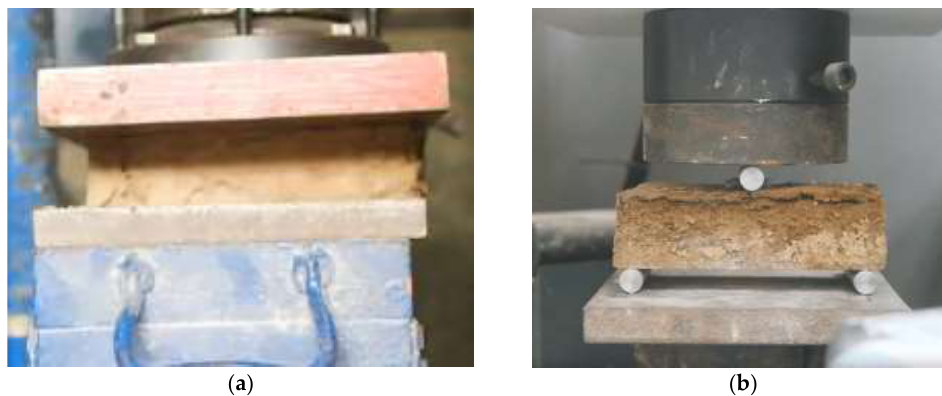
Figure 4. ( a ) Brick compression testing; ( b ) brick flexural strength testing. Figure 4. (a) Brick compression testing; (b) brick flexural strength testing. Figure 4. (a) Brick compression testing; (b) brick flexural strength testing.